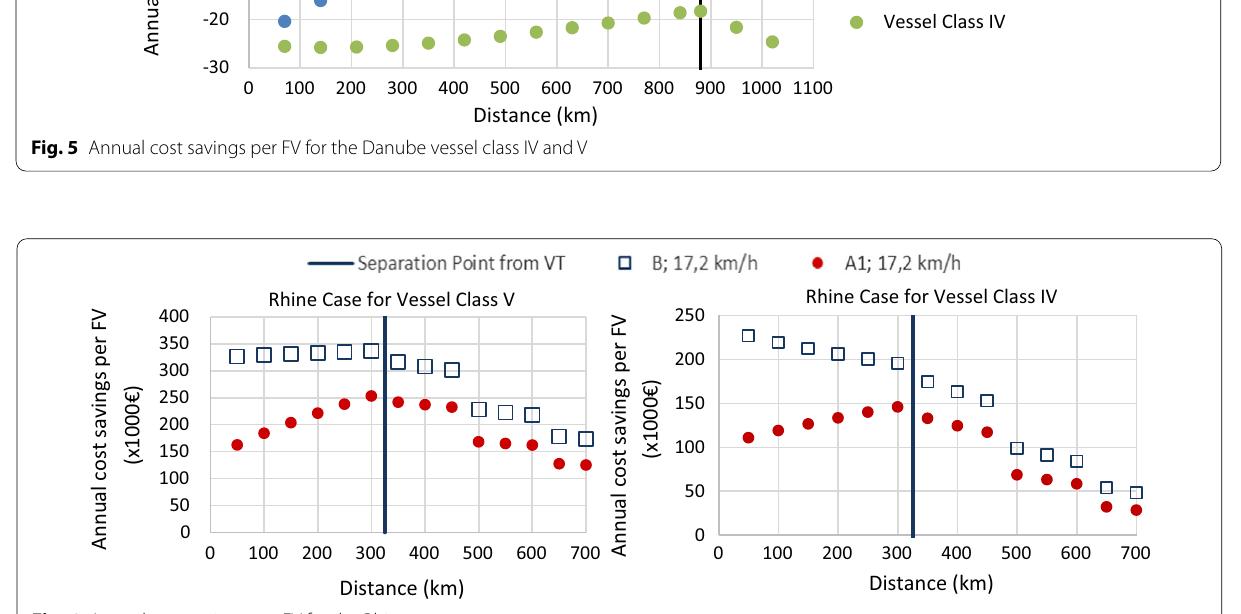
Fig. 6 Annual cost savings per FV for the Rhine